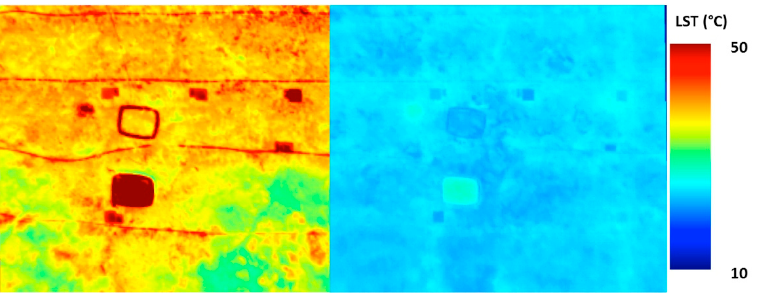
Figure 5. Thermal images (pseudo color composite) acquired at 13.21 (left panel) and 18.34 (right panel) solar